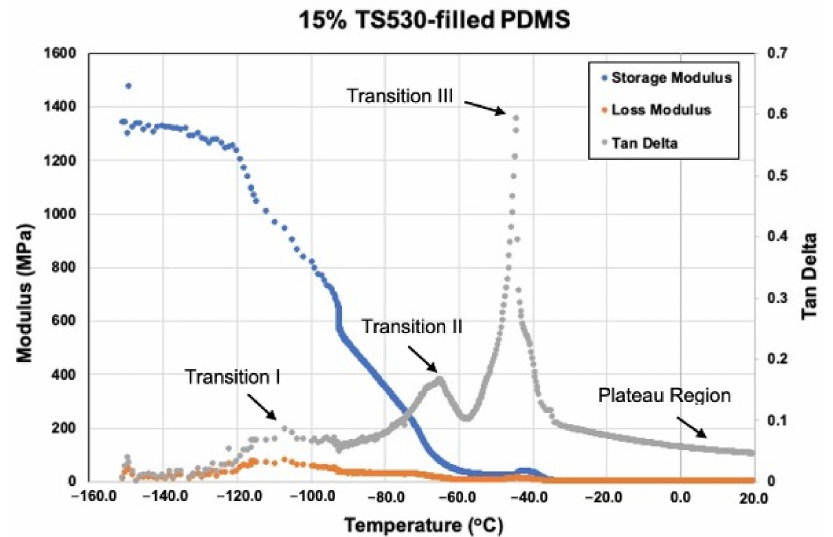
Figure 19. Storage Modulus, Loss Modulus, And Tan Delta Curves For 15% TS530-filled PDMS From − 150 ◦ C To +20 ◦